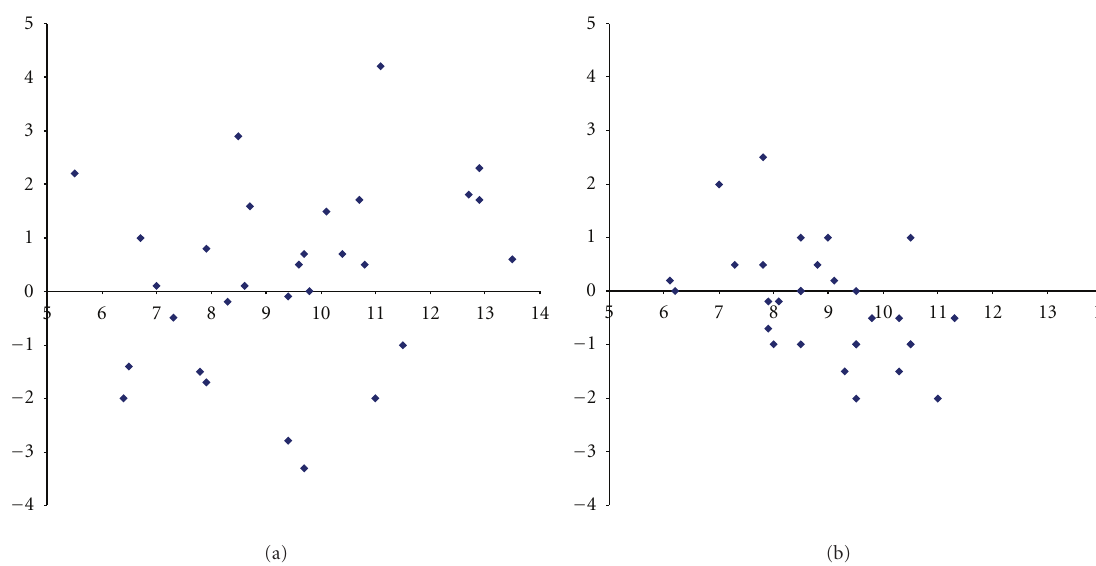
Figure 2: (a) Bland-Altman plot showing di ff erences for the sagittal mobility (cm) at the two measurements ( Y -axis) made by rater A versus the mean values of these measurements ( X -axis). Every dot represents one subject. (b) Bland-Altman plot showing di ff erences for the sagittal mobility (cm) at the two measurements ( Y -axis) made by rater B versus the mean values of these measurements ( X -axis). Every dot represents one subject.